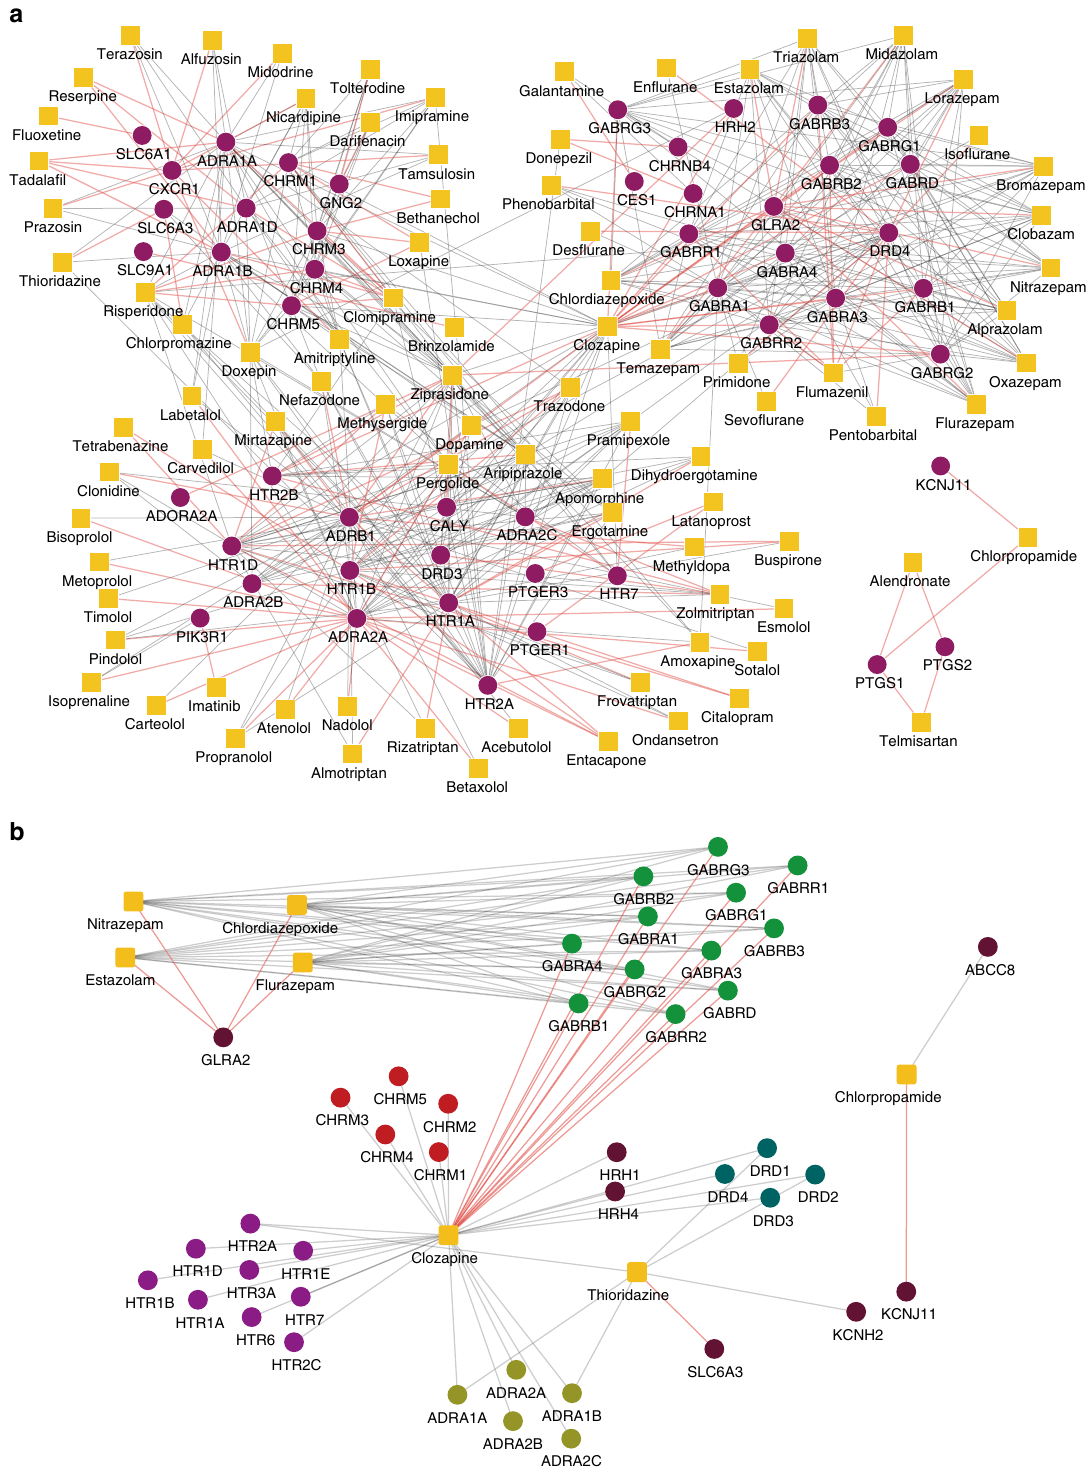
Fig. 4 Network visualization of the drug – target interactions predicted by DTINet. a Visualization of the overall drug – target interaction network involving the top 150 predictions (also see Supplementary Data 1). Target and drugs are shown in purple circles and yellow boxes , respectively. b Network visualization of several examples of novel DTI predictions which can be supported by known experimental or clinical evidence in the literature. The drugs are shown in yellow boxes , white different families of their interacting targets are shown in circles with different colors. In both a , b , known drug – target interactions are marked by grey edges , while the new predicted interactions are shown by red